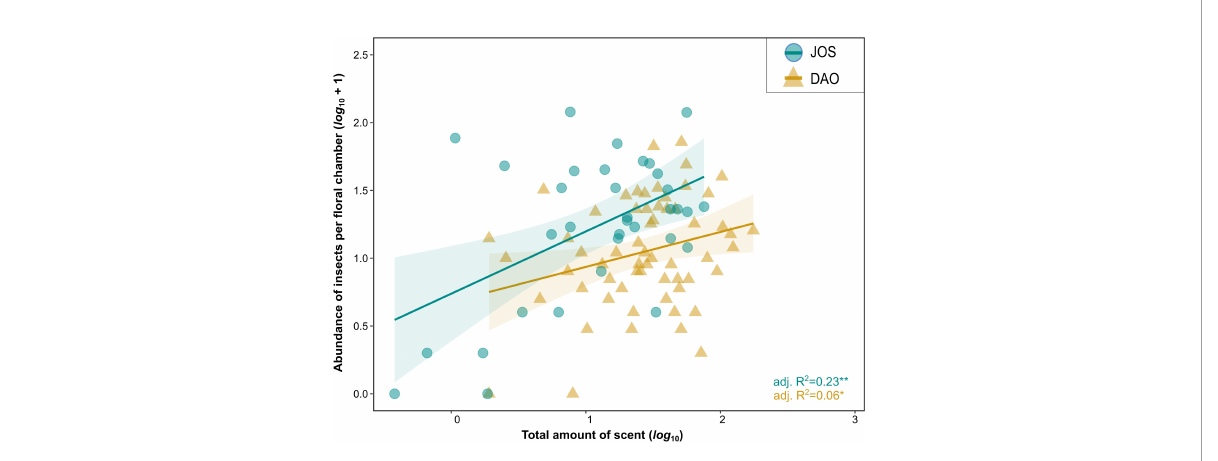
FIGURE 2 Linear regressions between the absolute abundance of fl oral visitors ( log 10 +1) trapped per fl oral chamber of Arum maculatum individuals and the total absolute amount of fl oral scent emitted per in fl orescence ( log 10 , ng in fl orescence -1 5 min -1 ) in populations JOS (Jose fi au, Salzburg, Austria) and DAO (Daone, Trentino, Italy). Solid lines indicate signi fi cant model fi tting and shaded areas represent 95% con fi dence intervals. * 0.01 < P ≤ 0.05; ** 0.001 < P ≤